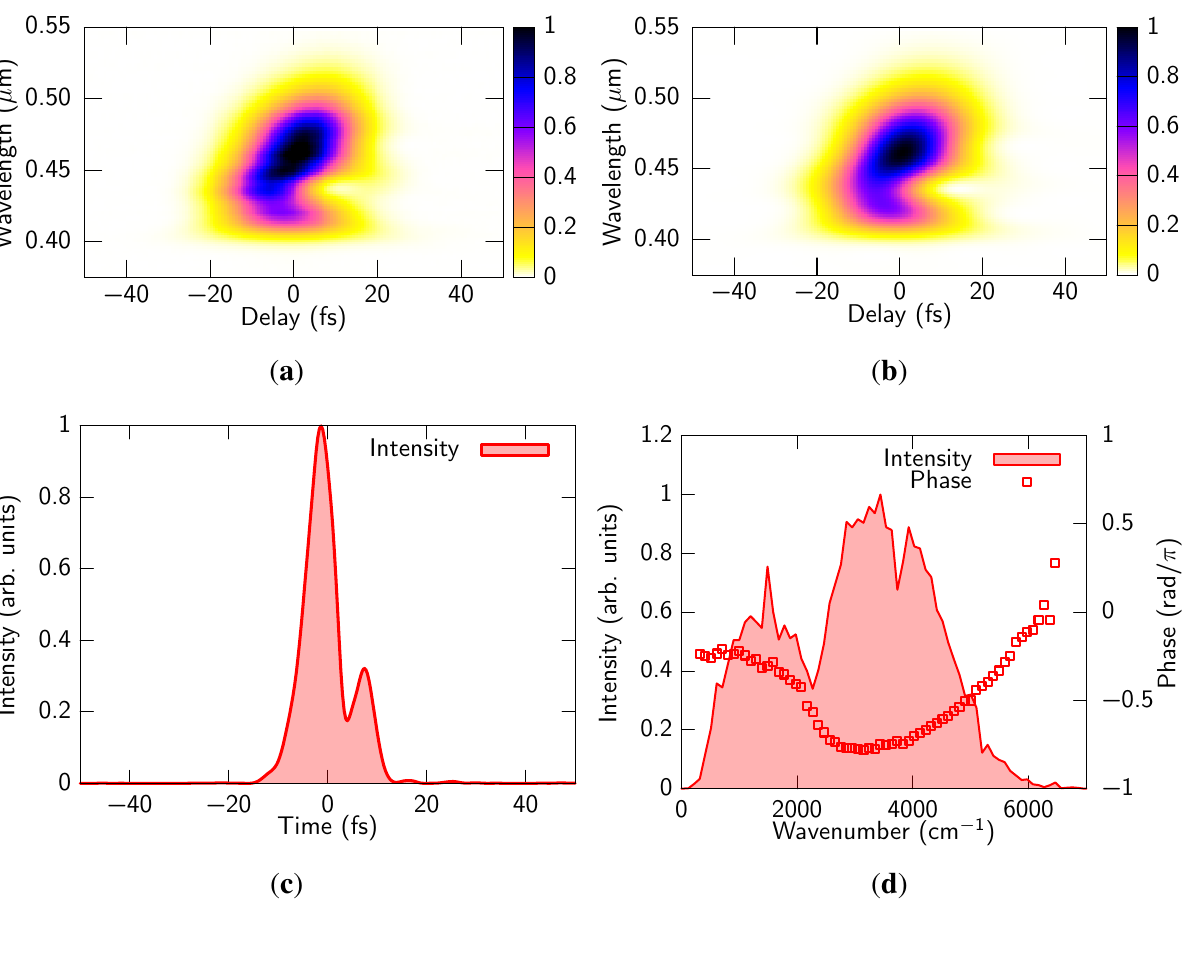
Figure 6. ( a ) Experimental and ( b ) retrieved XFROG traces. The retrieved pulse in ( c ) time and ( d ) frequency